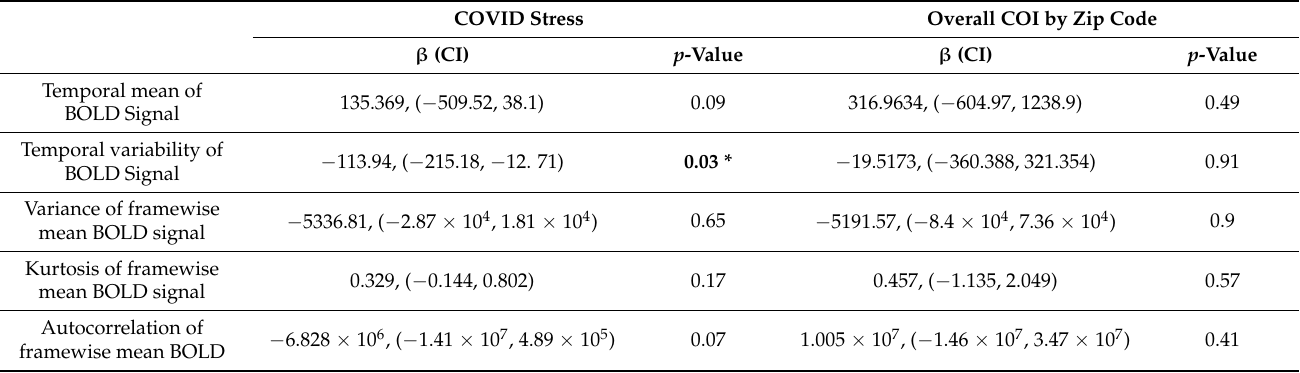
Table 4. Brain functional metrics’ relationship to COVID stress and COI-SEE using linear modeling. * denotes statistically significant